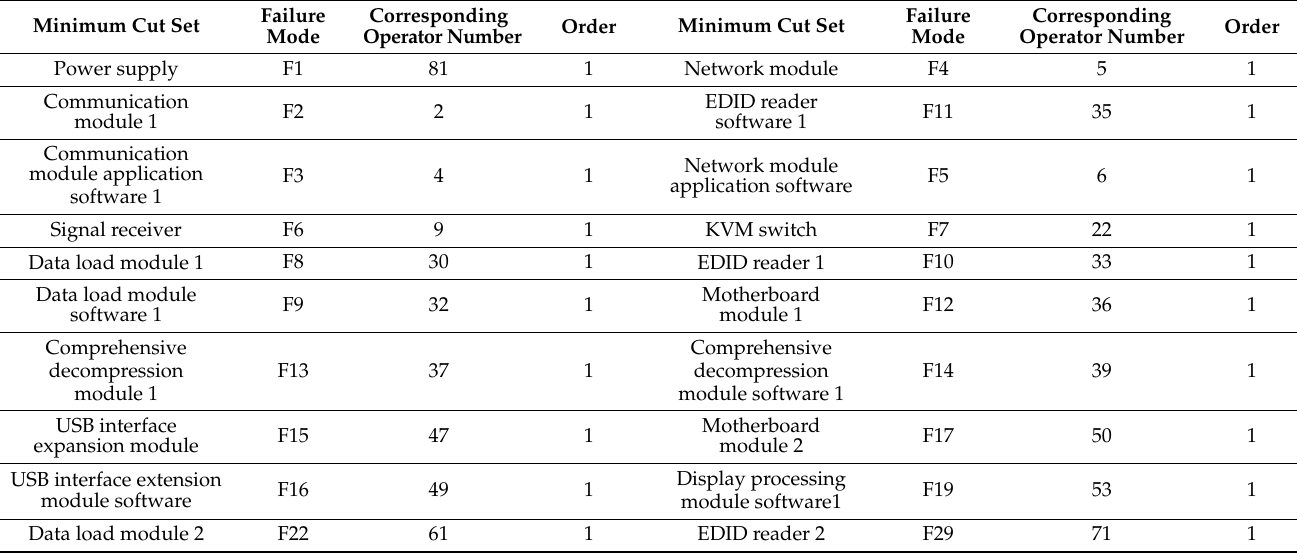
Table 5. Qualitative analysis results of the C 4 ISR